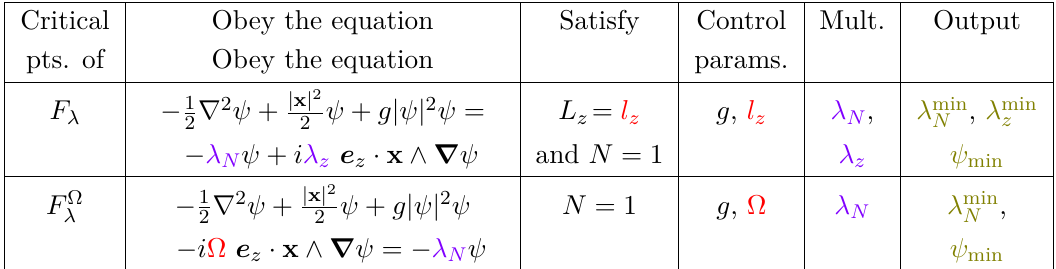
Table 2 . Summary of the differences: the red font shows the parameters that are given as input to the corresponding minimization problem. The purple font highlights the Lagrange multipliers. In a numerical simulation, these are sequentially adjusted according the Augmented Lagrangian Algorithm, until the constraints are satisfied (and the minima of F λ are found). The olive color fonts show the output quantities obtained in the numerical simulations.